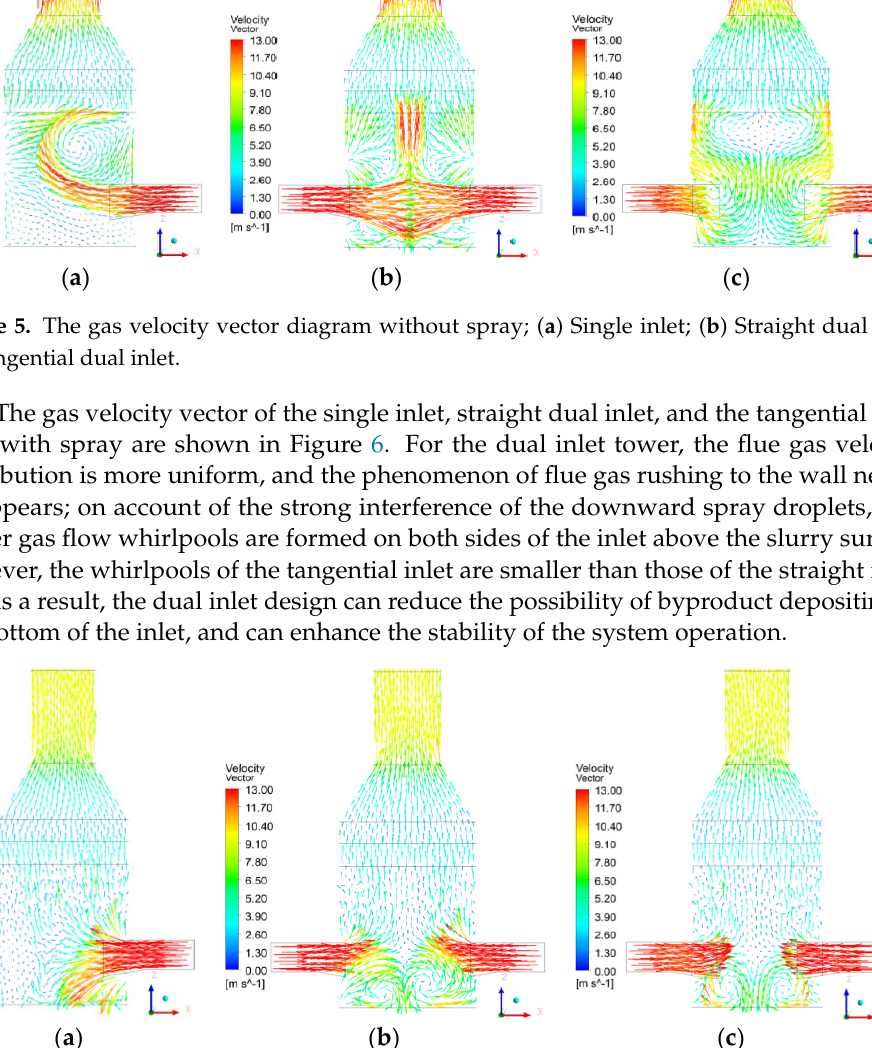
Figure 4. The gas phase streamlines without spray; ( a ) Single inlet; ( b ) Straight dual inlet; ( c ) Tangential dual inlet.